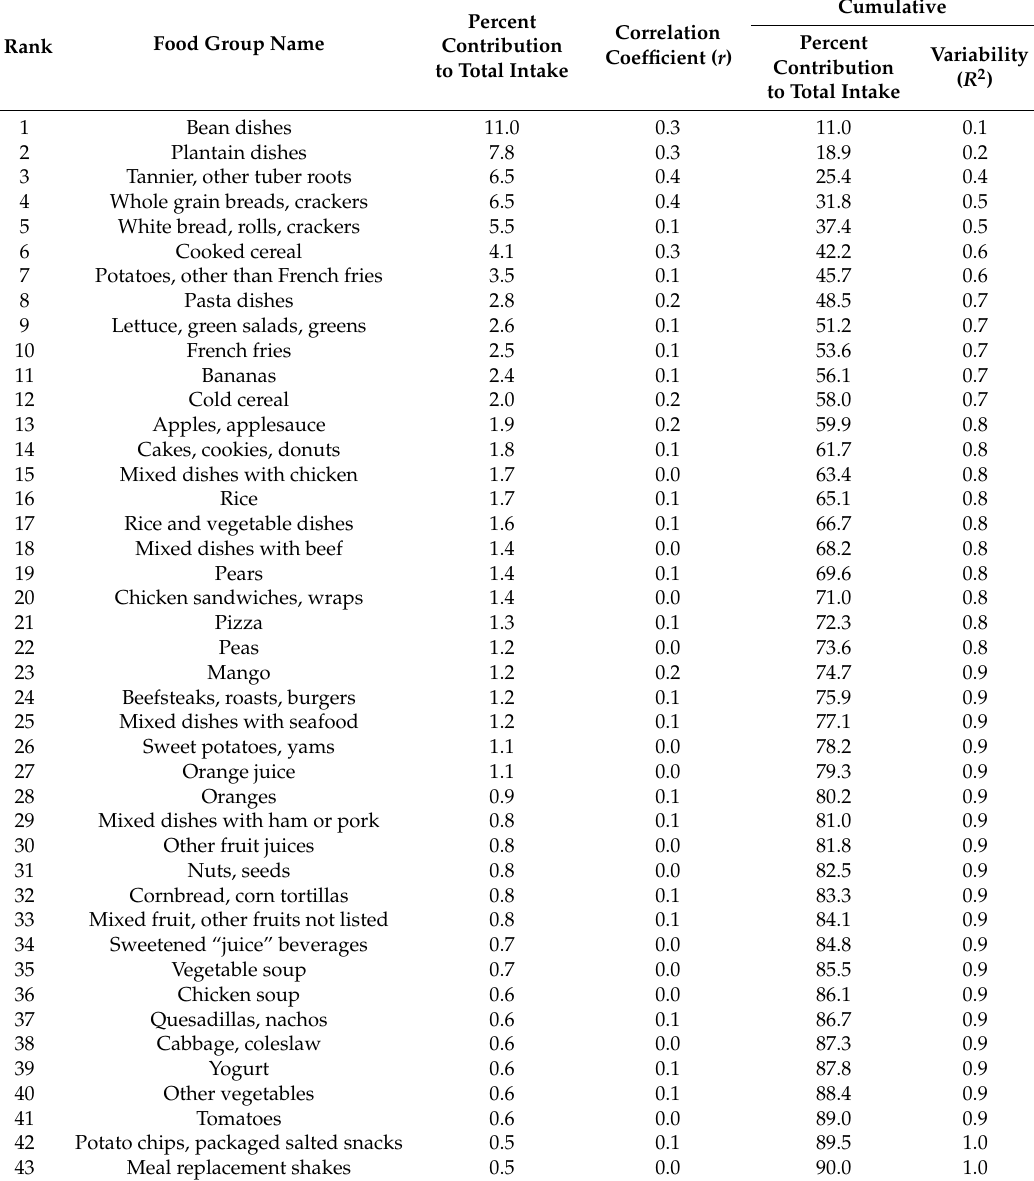
Table 5. Foods contributing to dietary fiber (g) intake, Puerto Rican